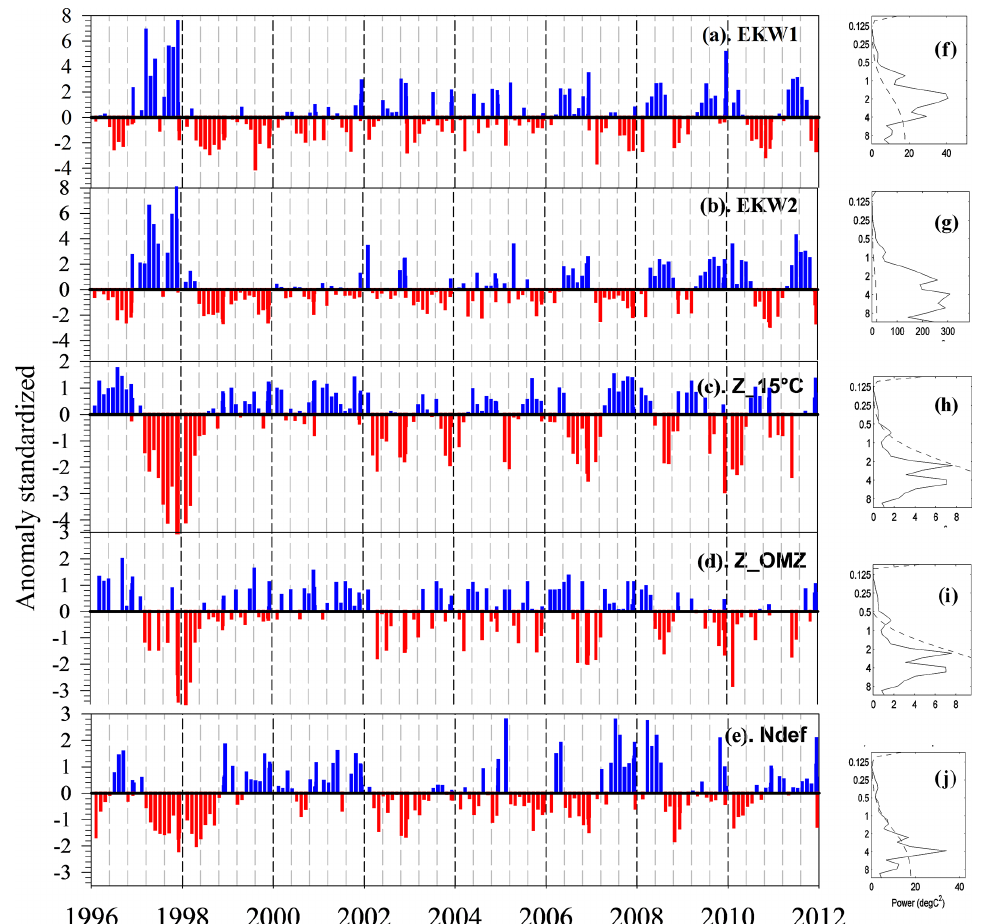
Figure 8. Evolution of the (a, b) amplitude of the equatorial Kelvin wave (EKW) anomalies at 90 ◦ W for the first (EKW_1) and second (EKW_2) baroclinic modes. Units are cm (equivalent sea level). The standard deviation is indicated by the horizontal dashed lines. The time resolution of the data is every 5 days. (c) Depth of the thermocline, (d) OMZ upper boundary depth and (e) fixed nitrogen deficit (Ndef) at 50m (f) at St. 4 off Callao during 1996–2011. On the right-hand side of each time series, the global wavelet spectra with a significance level at 95% are shown (g–j) . The 95% confidence level is estimated from red noise (Markov